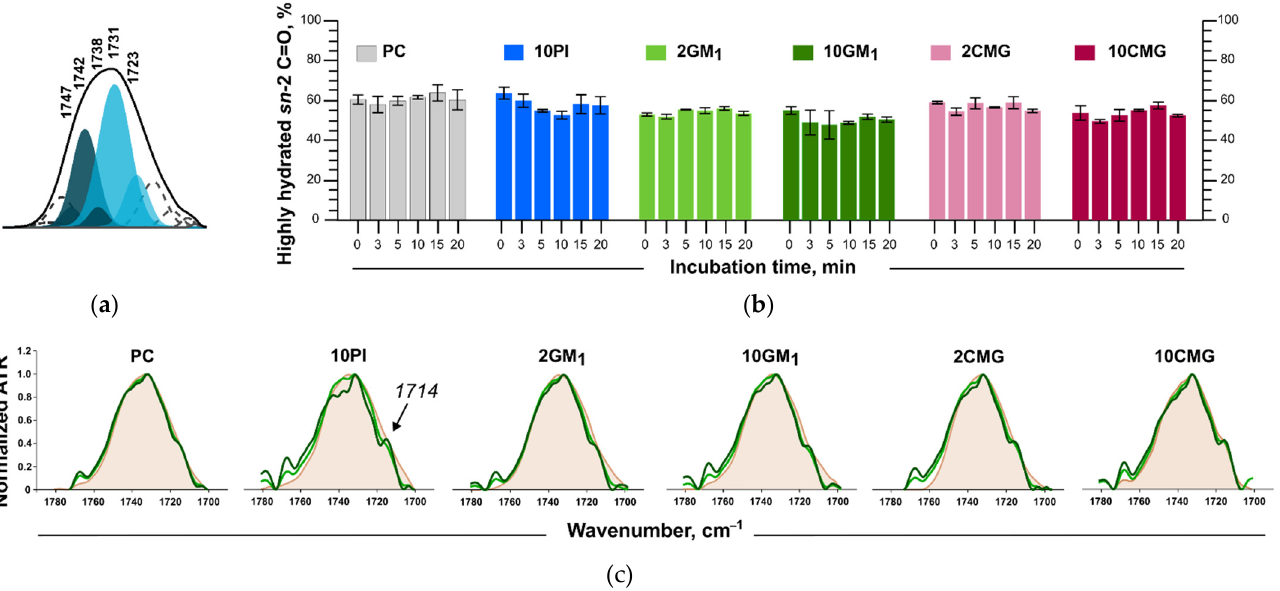
Figure 8. ( a ) C=O deconvolution example; ( b ) changes in the percentage of sn-2 C=O hydrated groups during incubation with BSA; ( c ) C=O region in FTIR spectra for liposomes alone (beige) and with albumin (shades of green). FTIR spectra were recorded in PBS at 37° С , lipid concentration of 12 mM, and albumin concentration of 6 mg/mL.